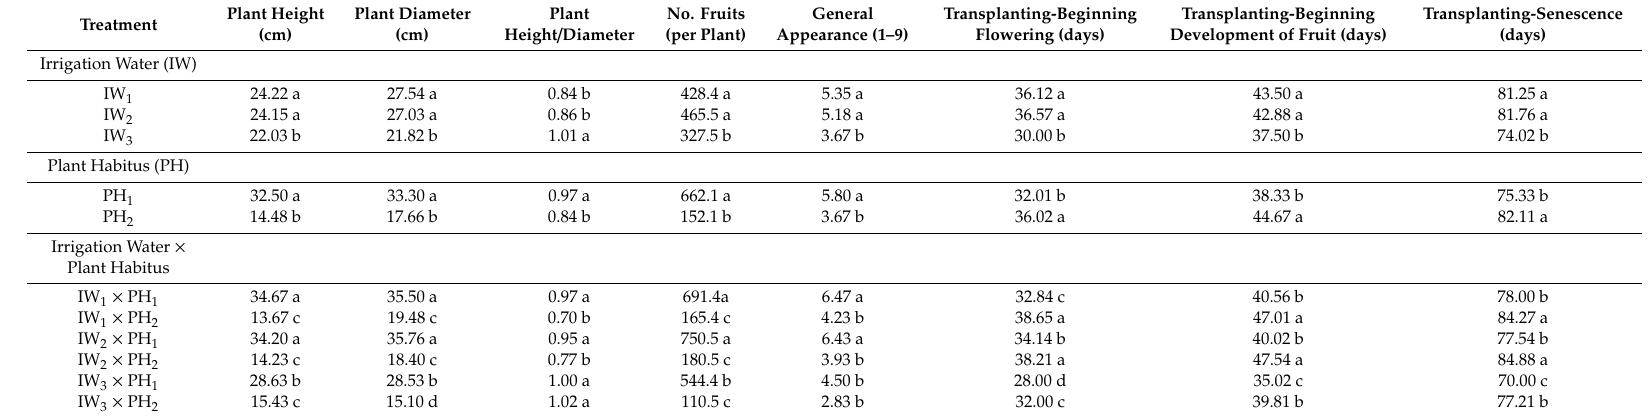
Table 7. Morphological, aesthetic and phenological characteristics of erect and pendant plants of ornamental pepper irrigated with FW, TFFSW and FFSW.